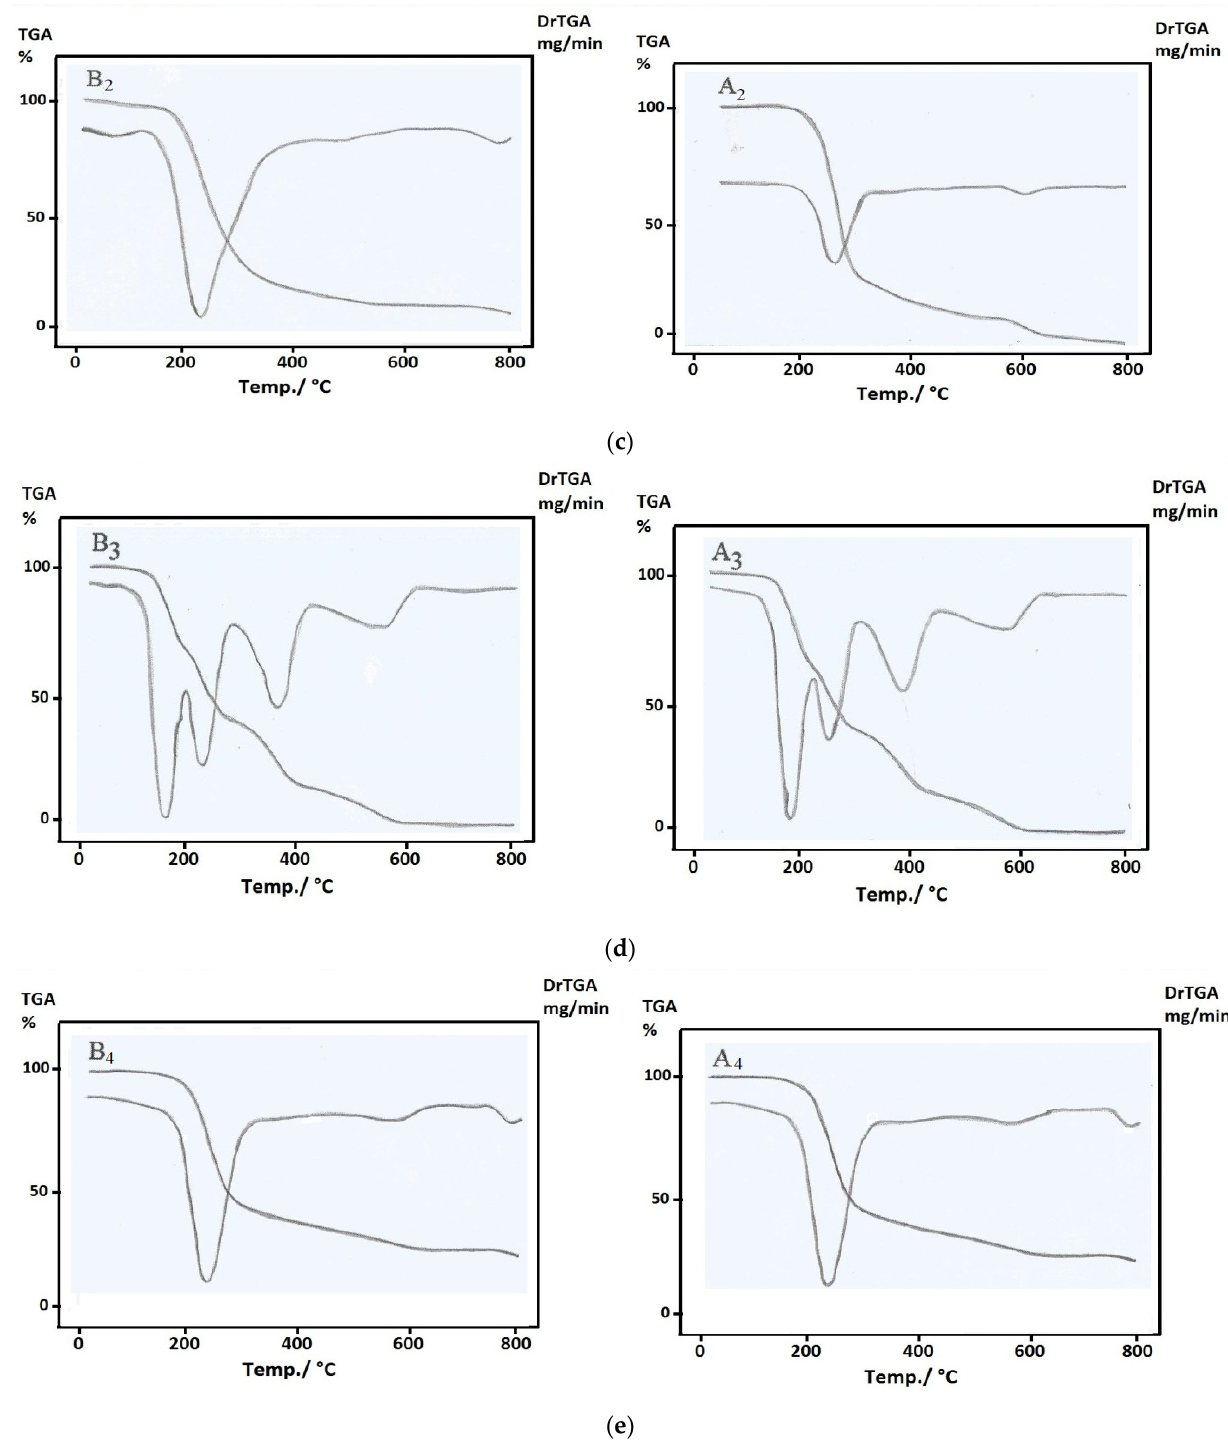
Figure 5. ( a ) . TGA/DTG curves of the ligand before (B) and after (A) irradiation. ( b ) TGA/DTG curves of the Pb(II) com- plexes before irradiation (B 1 ) and after irradiation (A 1 ). ( c ). TGA/DTG curves of the Mn(II) complexes before irradiation (B 2 ) and after irradiation (A 2 ). ( d ). TGA/DTG curves of the Hg(II) complexes before irradiation (B 3 ) and after irradiation (A 3 ). ( e ). TGA/DTG curves of Zn(II) complexes before irradiation (B 4 ) and after irradiation (A 4 ).